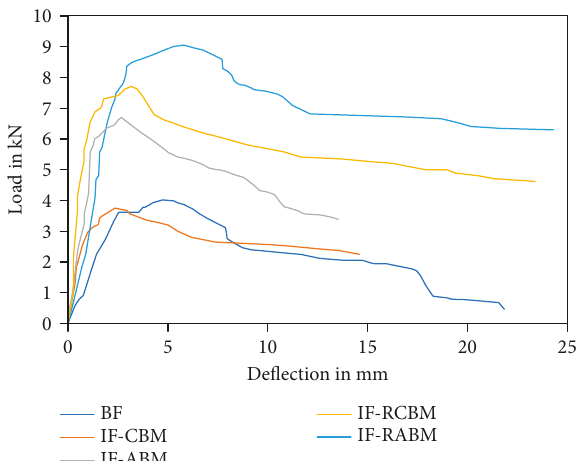
Figure 5: Load-deflection